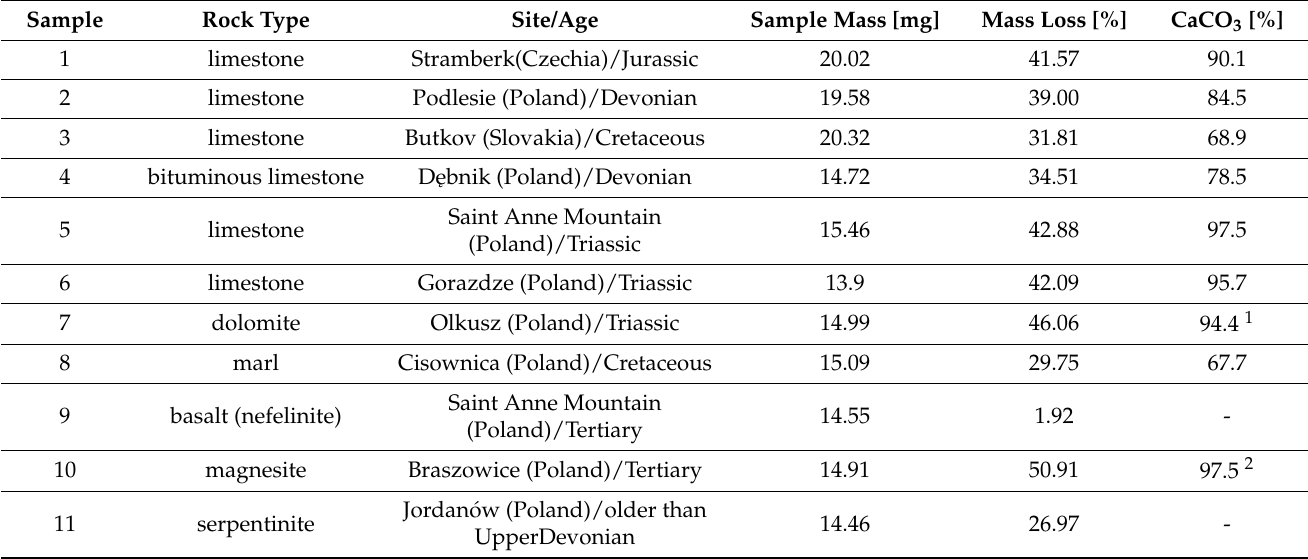
Table 1. Samples studied as potential sorbents in the CaL